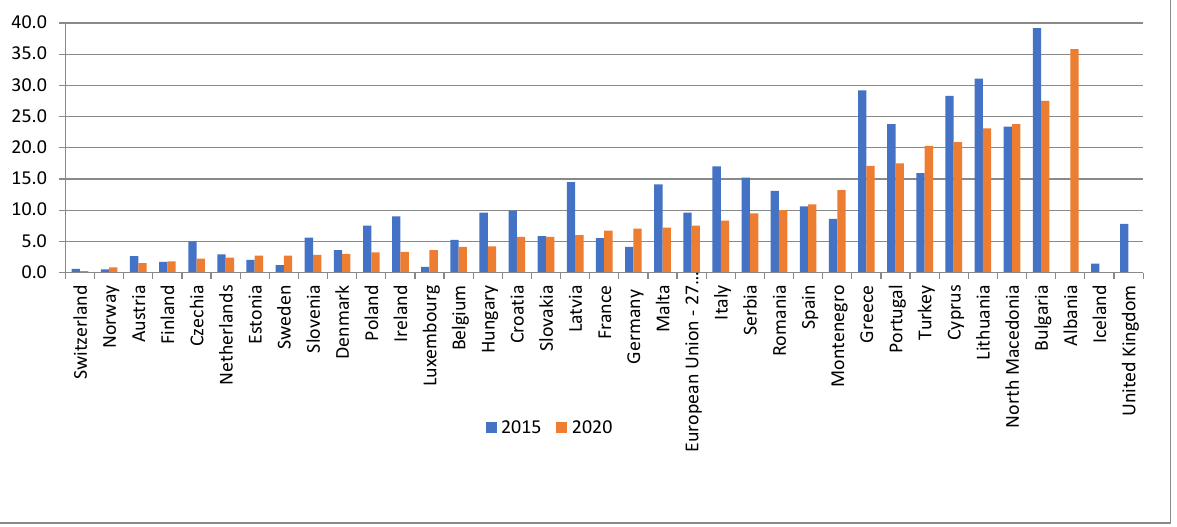
Figure 5. Percentage of the population that is unable to keep home adequately warm in European countries during 2015 and 2020. Source: own preparation based on Eurostat database [47].